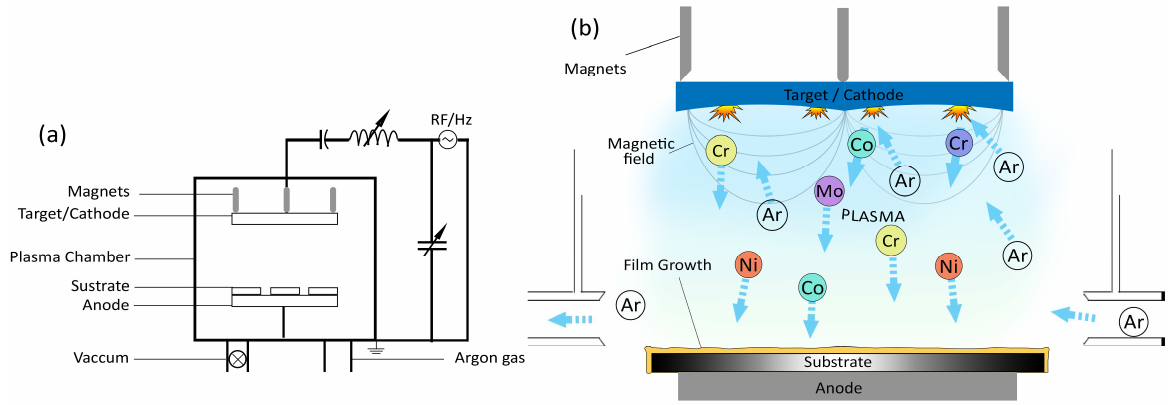
Figure 1. ( a ) Line diagram of radiofrequency (RF) magnetron sputtering; ( b ) Inside view of HEA sputtering process in the chamber.